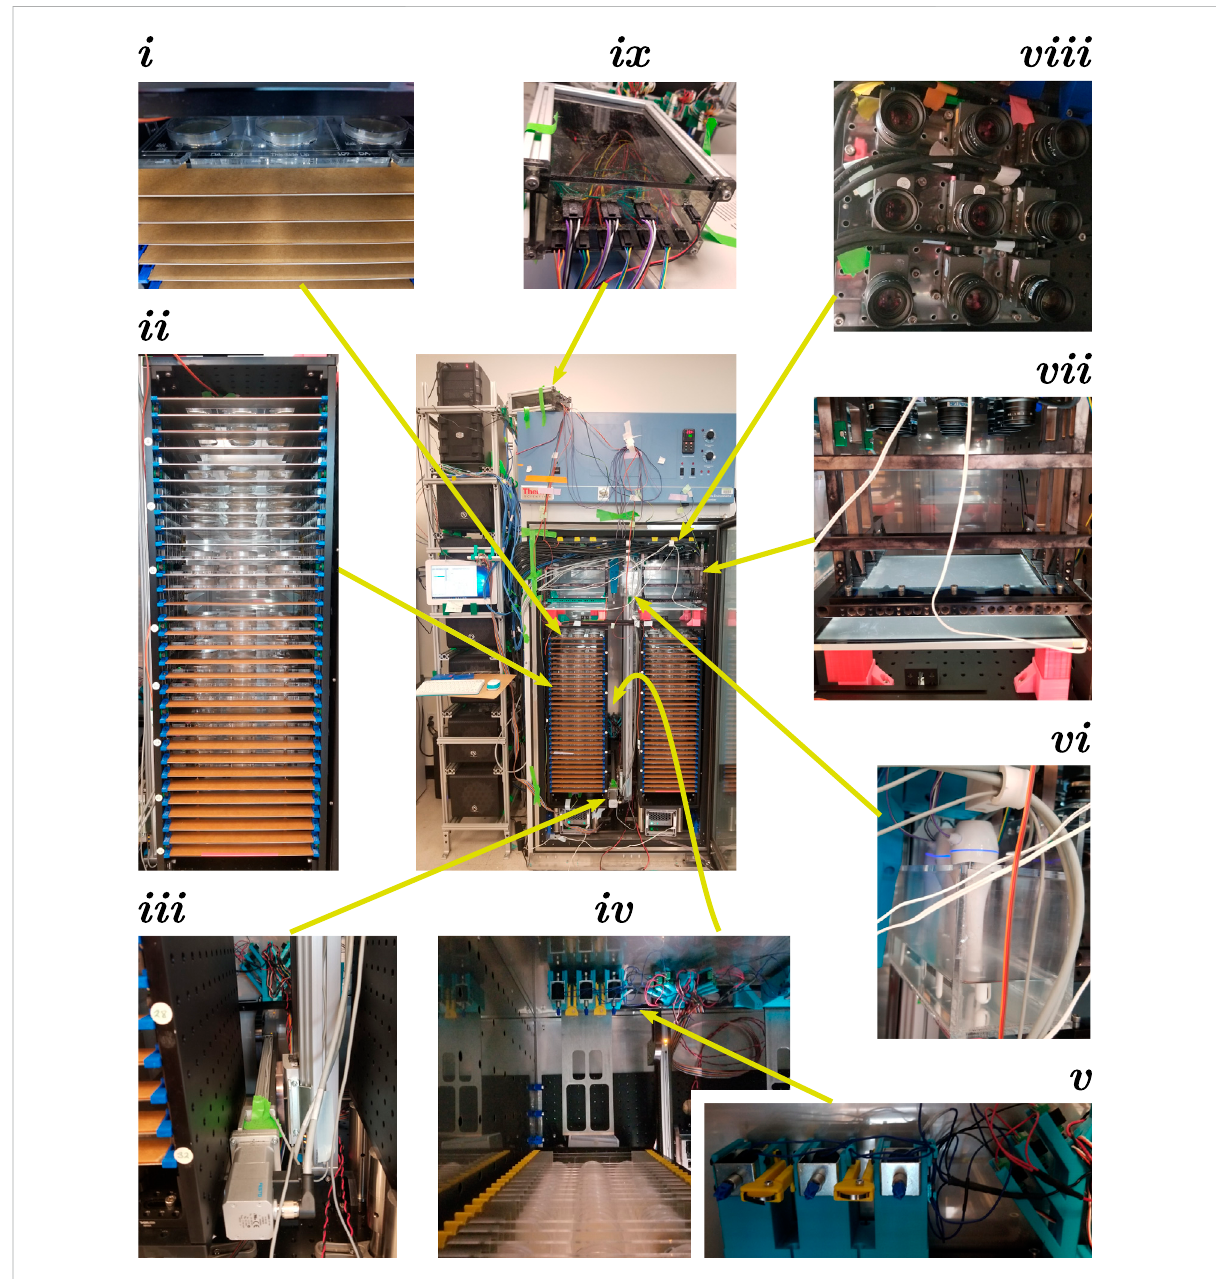
FIGURE 2 C.elegans ObservatoryHardware.Center:AssembledObservatoryincludingcomputertower(left)andincubatorwithcustomhardware(right). Worms on 6 cm plates are mounted in acrylic trays that are placed into a tower (i); the full tower contains 32 slots for trays (ii), and there are two towers per incubator. Trays are moved via a two-axis linear motion system (iii), with a forklift-style assembly to lift the trays from behind (iv). The forklift also braces the tray in position when on the imaging platform and contains solenoids to deliver mechanical stimuli (v). A custom humidi fi er box (tank + mini-desktop humidi fi ers) maintains humidity (vi). The imaging platform (vii) consists of a light box mounted on top of the tower, and a frame mounted to the ceiling that holds the tray in a fi xed position relative to the ceiling-mounted camera array (viii). Temperature and humidity are monitored and maintained with the aid of a custom electronics box (ix) containing a small Arduino-style processor (Teensy 3.2) that reads sensors and controls humidi fi ers and the incubator